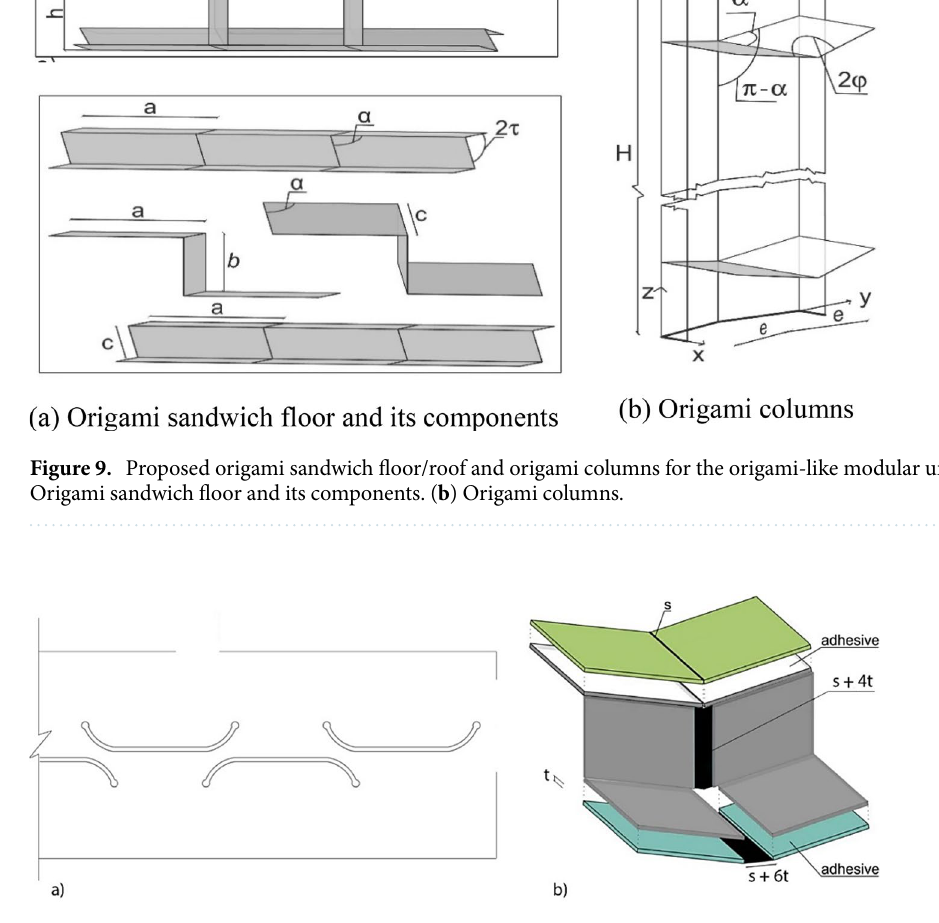
Figure 10. ( a ) A steel compliant joint 30 . ( b ) The space allocated to the compliant joints and the position of the adhesives within the origami sandwich